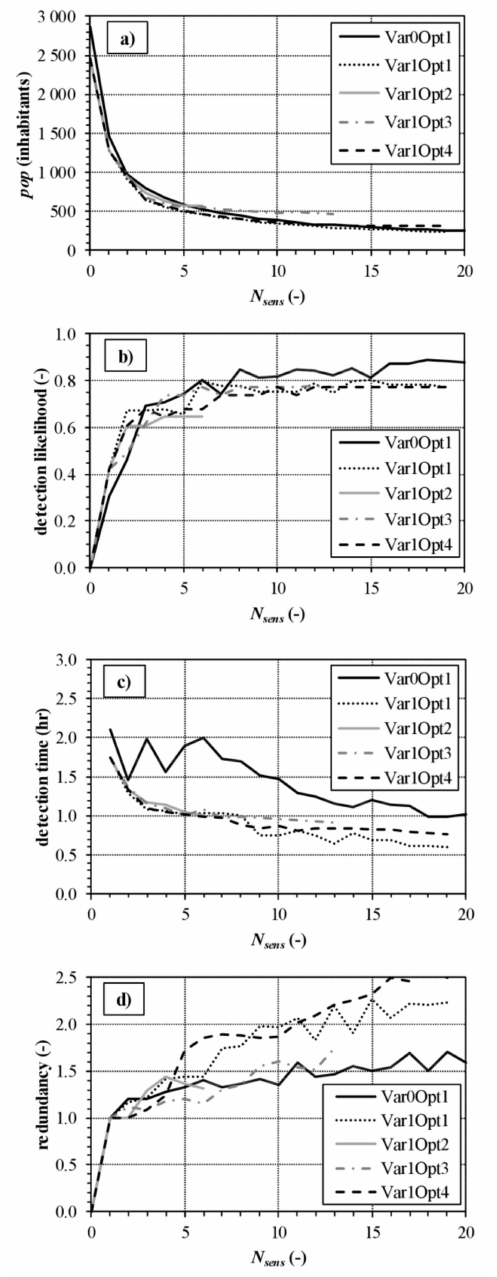
Figure 3. For the original un-partitioned WDN ( Var0Opt1 ), reported as benchmark, and for the partitioned WDN ( Var1Opt1, Var1Opt2, Var1Opt3 and Var1Opt4 ), Pareto front of optimal sensor placement solutions in the trade-o ff between N sens and contaminated population pop ( a ), re-evaluated solutions in terms of N sens and detection likelihood P s ( b ), N sens and detection time T mean ( c ), and N sens and redundancy Red ( d